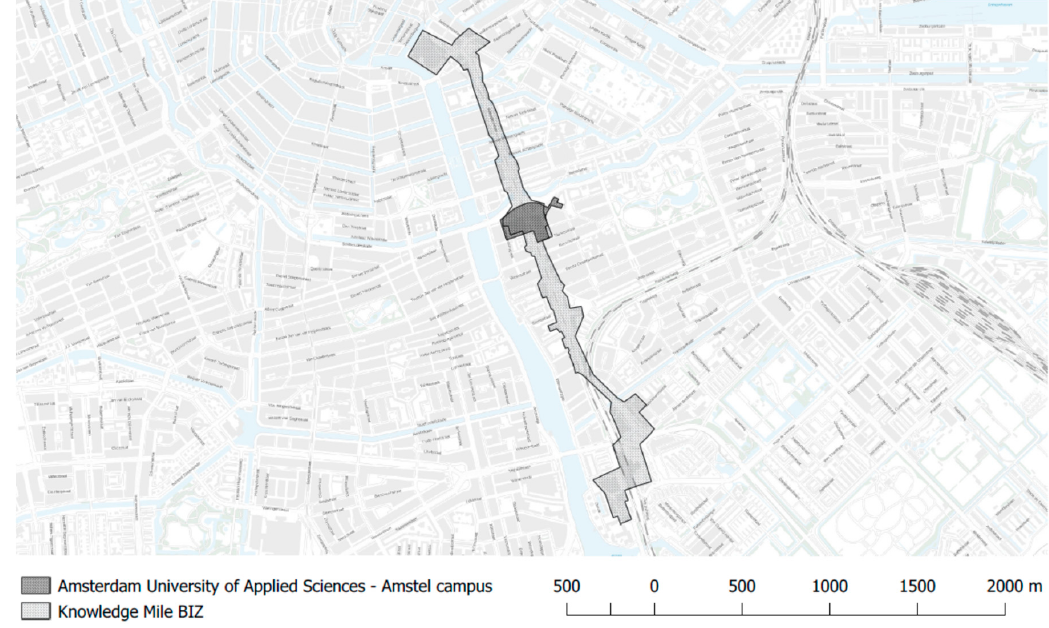
Figure 1. Map: The Knowledge Mile. BIZ, business investment zone.